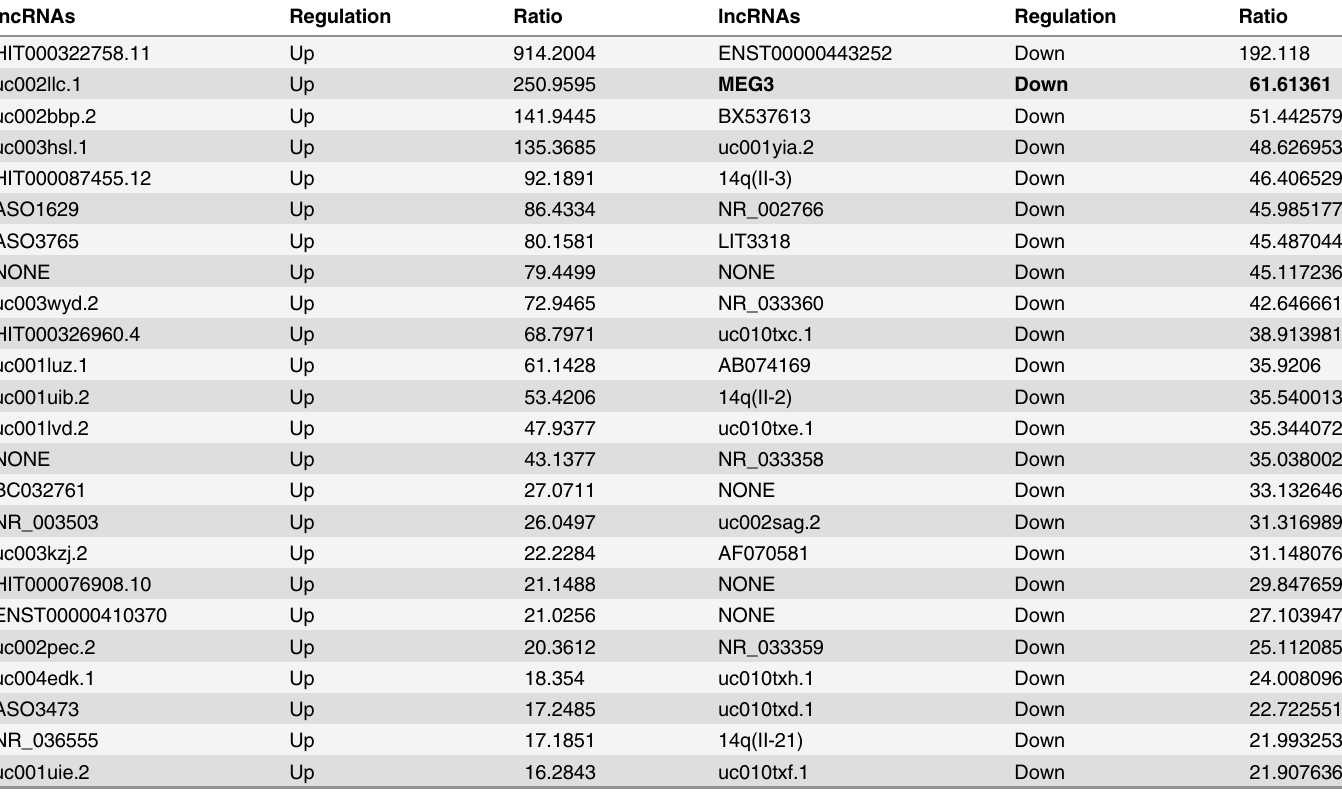
Table 1. Differentially expressed lncRNAs in A549/DDP cells compared with A549 cells as determined by microarray.